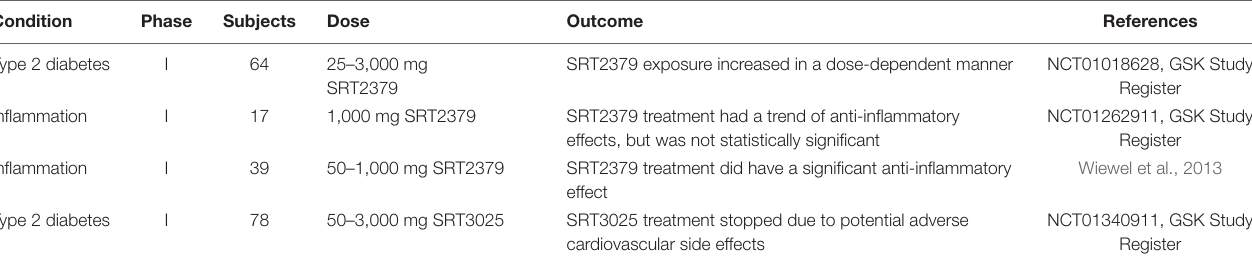
TABLE 11 | Clinical trials of SRT2379 and